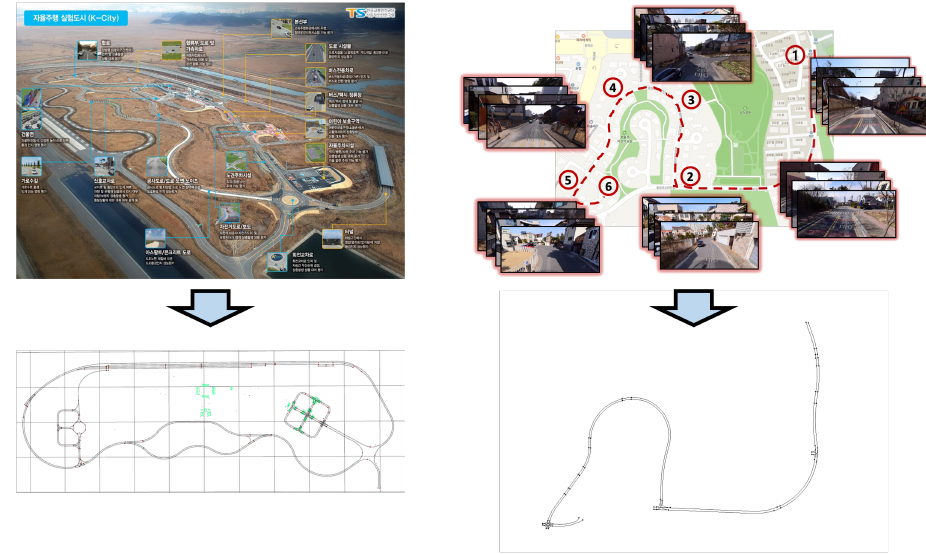
Figure 19. Experimental and actual residential